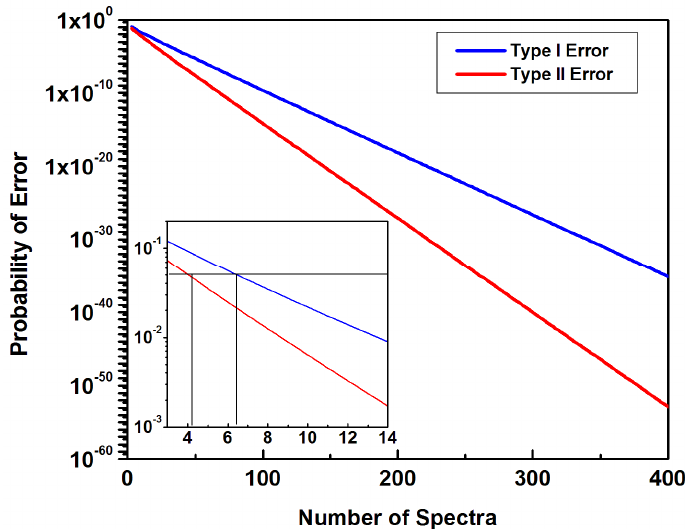
Figure 6. Probability of Type I and Type II errors versus the number of randomly chosen spectra employed in the classification. The black lines in the inset indicate that a relatively small set of measured spectra is sufficient to classify the samples with a typical p < 0.05 error probability.